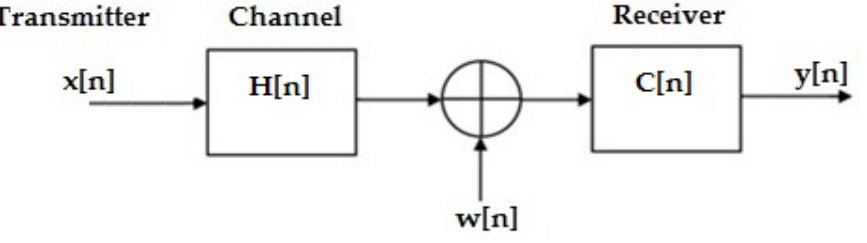
Figure 1. The digital transmission chain [10].